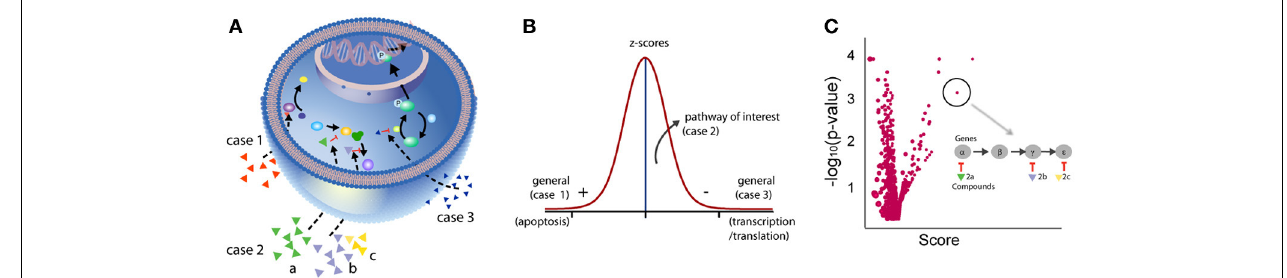
FIGURE 3 | Analysis of the entire bioactivity dataset. Examining biological annotations for the entire dataset including activity outside the extremes can rescue weak activity. (A) Depicted are three cases where compounds modulate cell signaling. In case 1, a compound shows high activity through, for example, activation of apoptosis. In case 2, three compounds are annotated to targets known to function in the same signaling pathway but each compound shows weak activity in the assay. In case 3, a compound shows strong activity in the assay acting through inhibition of general mechanisms such as transcription/translation. (B) While compounds in case 1 and 3 are easily captured using standard statistical thresholds, compounds in case 2 may only be rescued by